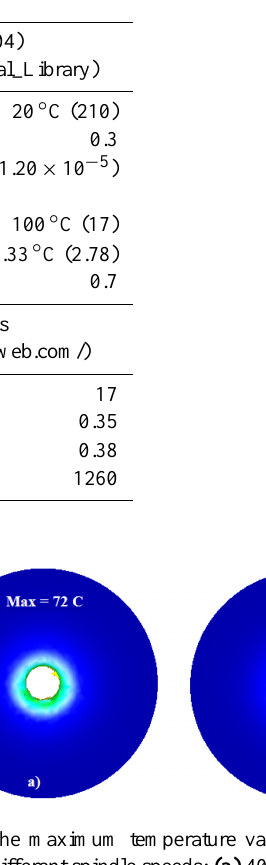
Table 2. Mechanical and thermal properties of the drill bit and bone model materials.